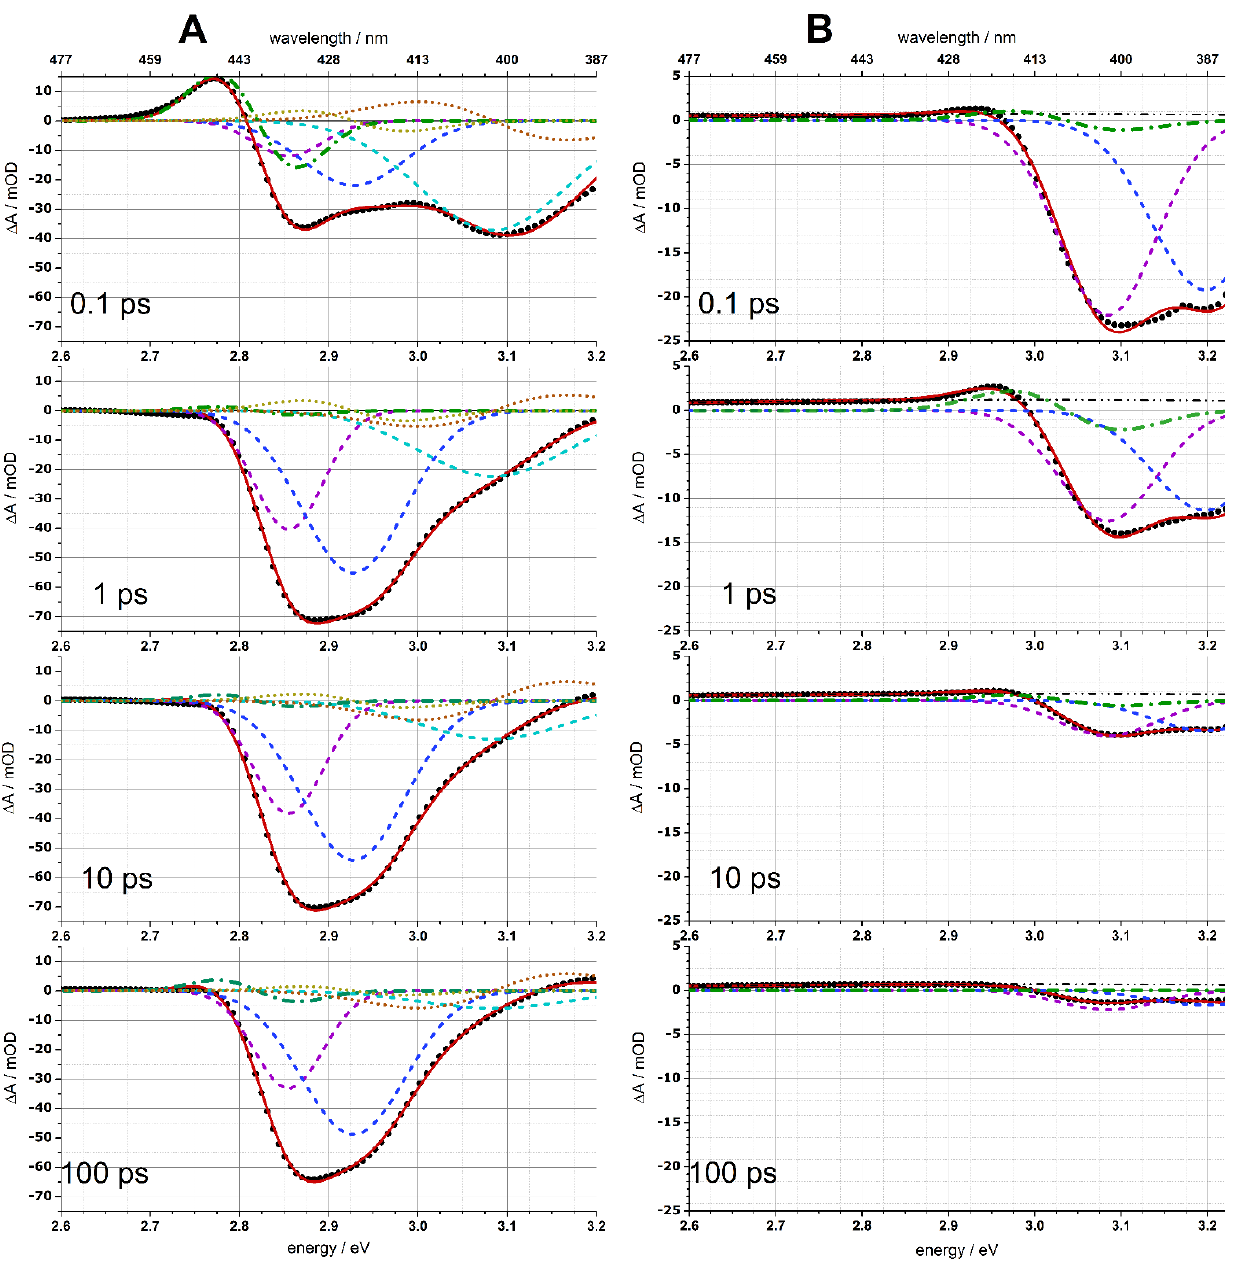
Figure 7. TA spectra at different delay times after 30 fs, 360 nm pump. ( A ) QD-1, without Mn 2+ ions. ( B ) Mn 2+ -doped QD-2. TA experimental data are shown as black circle marks. Solid red lines represent the fitting model (Equation (3)) with parameters in Table 1. BL bands are X 1 (violet, dashed), X 2 (blue, dashed), X 3 (cyan, dashed). Stark spectral feature of the band-edge exciton ( X 1 ) is indicated by S-like dash-dotted green lines. The Stark features of X 2 and X 3 excitons are indicated by yellow and brown dots, respectively.